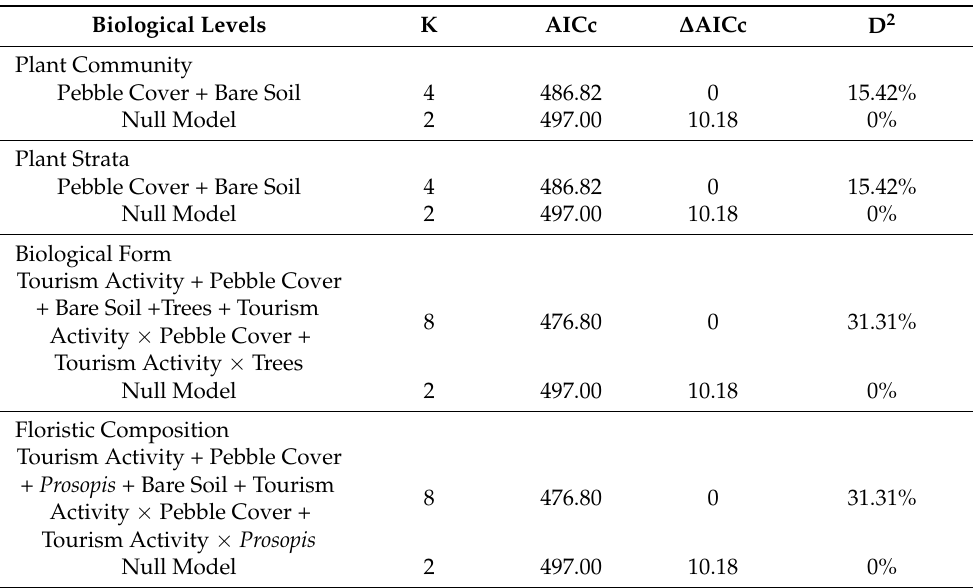
Table 1. The best models of habitat use of mara for each biological study in the Ischigualasto Provincial Park.